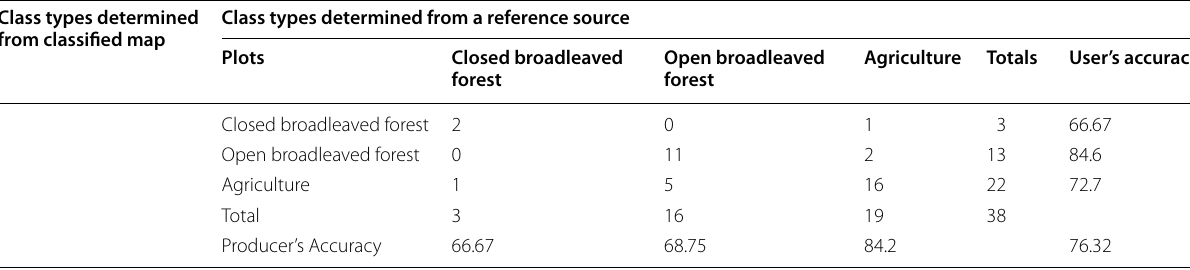
Table 6 Table illustrating calculation of user’s accuracy and producer’s accuracy Class types determined from classified